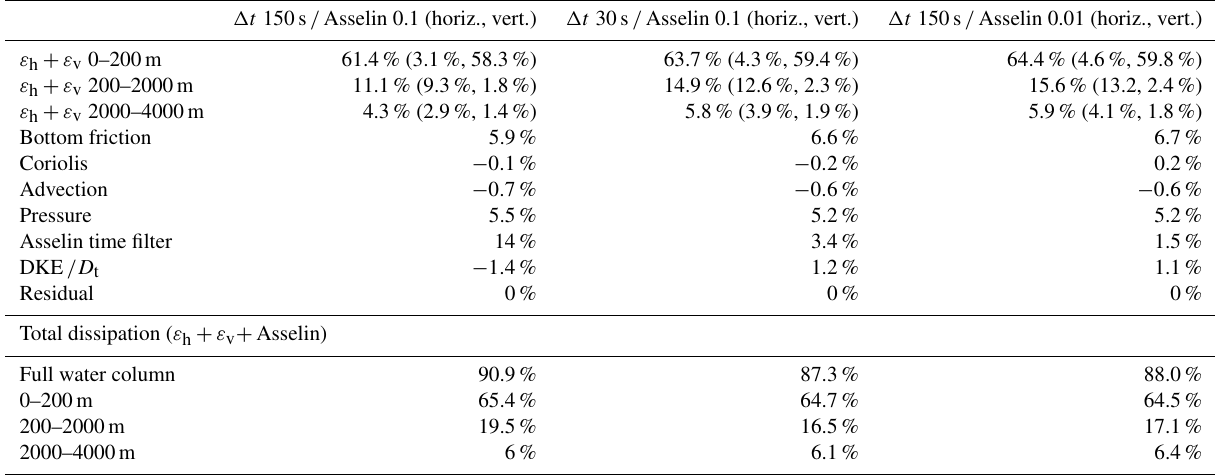
Table 3. Cumulated energy dissipation at day 70 (see Fig. 10) relative to a reference experiment without a storm, for three single-storm experiments with different time step and Asselin time filter coefficient. Results for the reference experiment described in Figs. 5, 8–10 are shown in the first